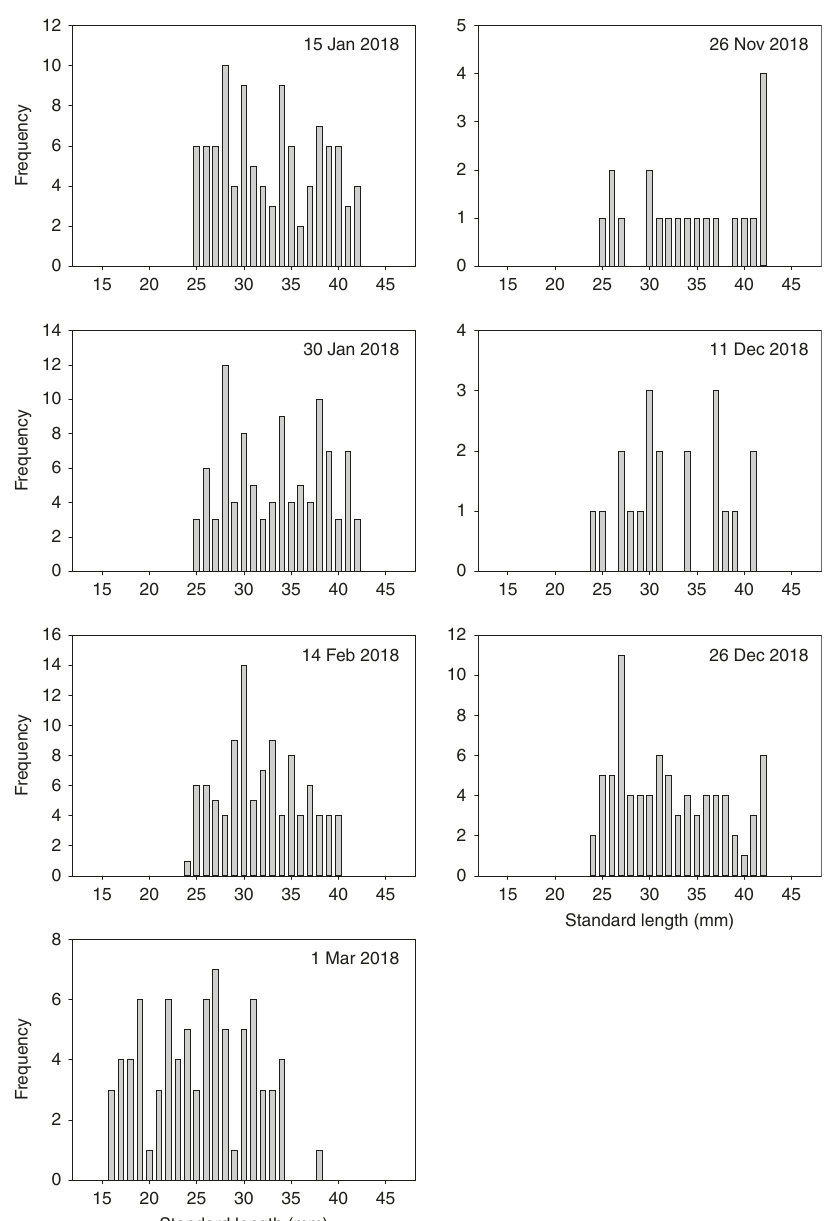
Fig. 3 Krill length frequency. Population frequency of krill standard lengths, based on uropod lengths of exuviae caught in the sediment trap. Note: only months with a signi fi cant number of exuviae were selected for the calculation. Subplots are labelled according to the date the sediment trap bottle